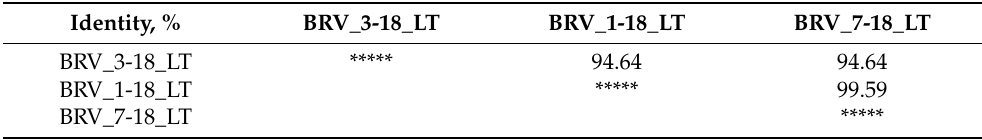
Table 1. Percent identity of BRV isolates at nucleotide level of RNA2 3 (cid:48) NTR regions found in Lithuanian cv.